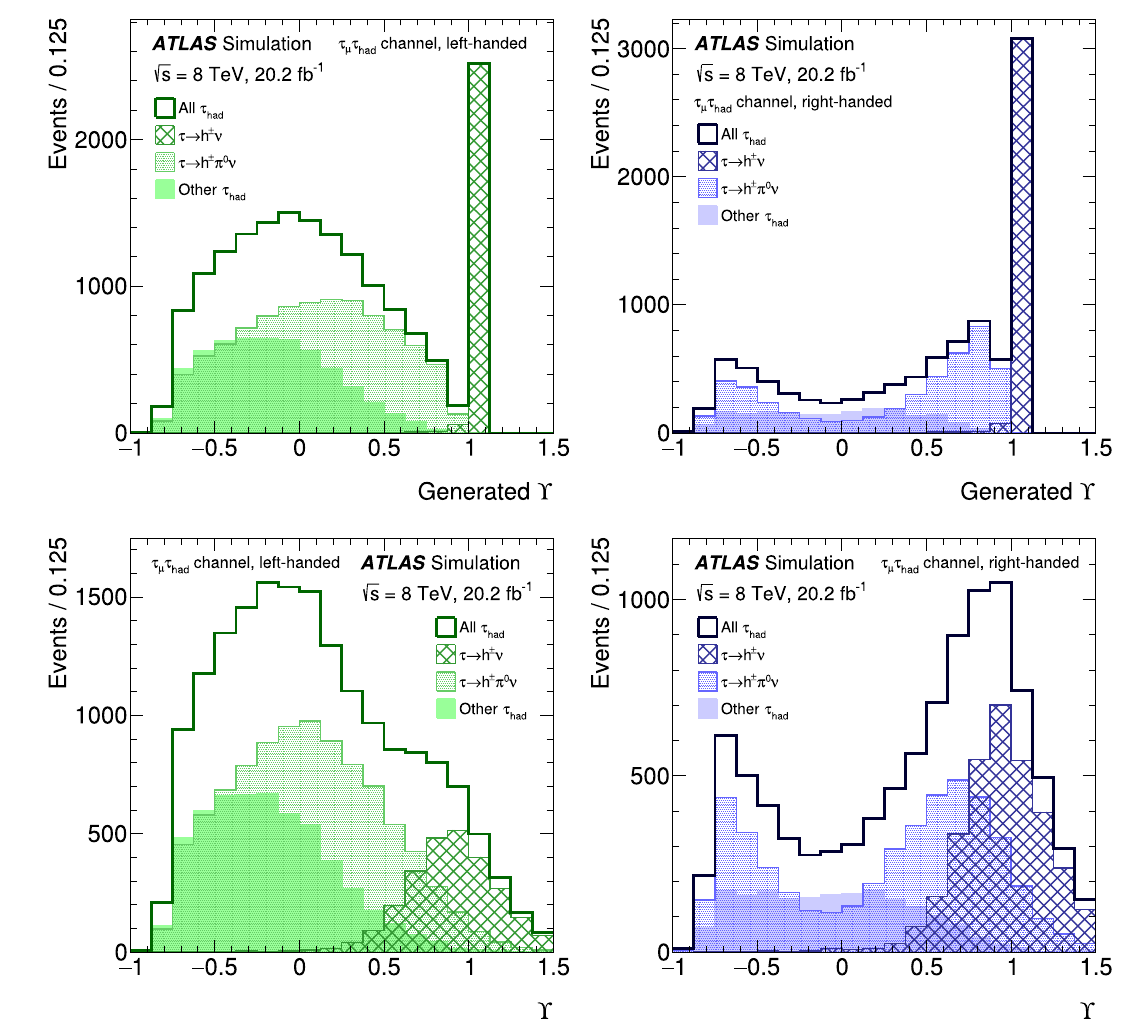
τ → h ± π 0 ν ( h ± denotes π ± or K ± ) modes are overlaid, as well as that of the remaining decay modes. The latter mainly consist of τ → h ± N π 0 ν decays, where N ≥ 2. The analysis does not, however, distinguish between the decay modes. The distributions are normalised according to their respective cross-sections. Here, the polarisation is taken from the simulation